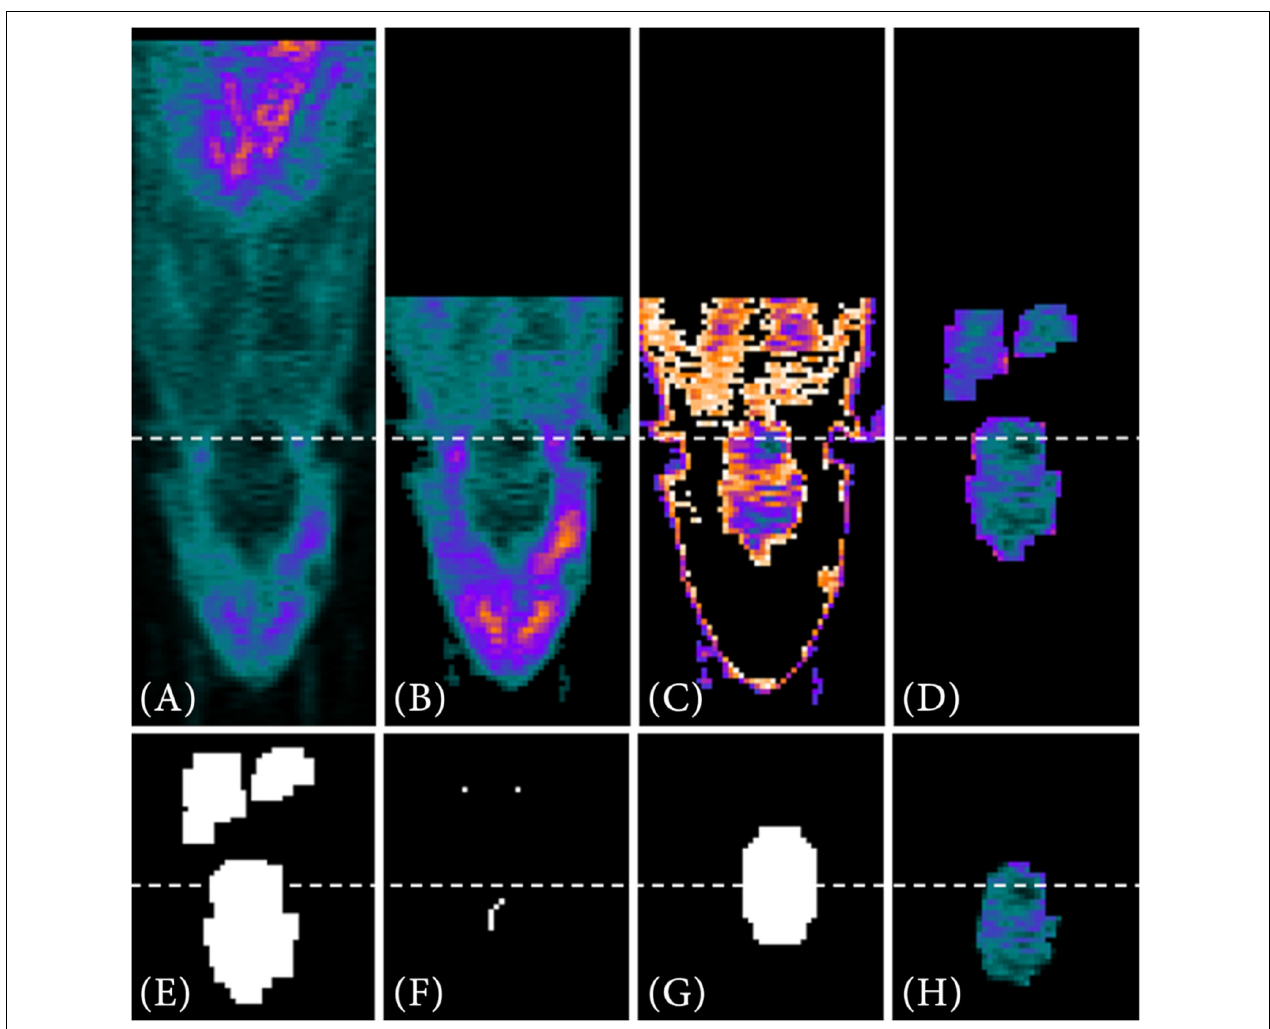
FIGURE 4 | VOI segmentation steps for a target-selective radiotracer. First, the full PET image (A) is reduced using prior information (B) , such as the manual positioning of the small animal in the tomograph. Automatic threshold approximation using Otsu method (C) and pre-implemented Matlab morphological operations (D) further reduce the data. Next, a binary image is generated from the remaining PET data (E) . Using the lower resolution MRI atlas set as a binary image (G) and the interior voxels of the binary image as starting points (F) , the image is searched for the VOI via contour matching. In (H) the segmented VOI is shown as